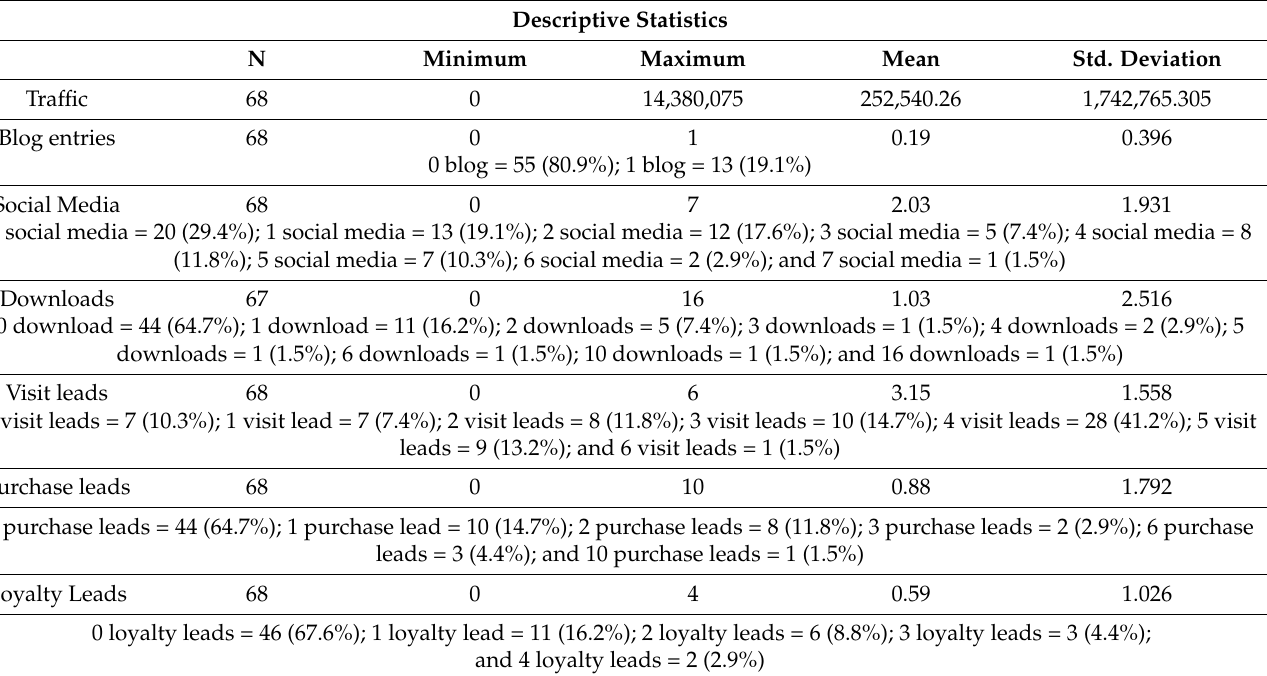
Table 4. Frequency and descriptive statistics of the Canary Islands’ museums websites. Descriptive